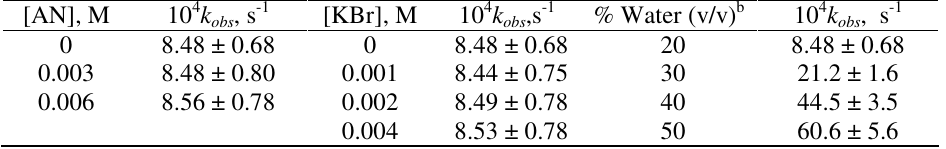
Table 3. Influence of added acrylonitrile (AN), KBr and solvent composition on reaction rate for the oxidation of PTAA with NCSA at 298 K a